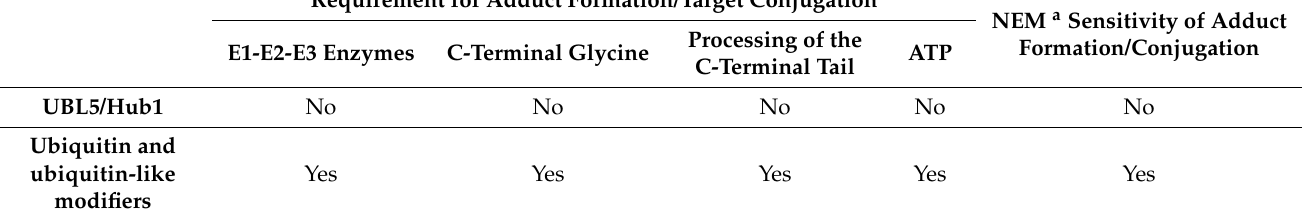
Table 1. Characteristics of adduct formation/target conjugation with UBL5/Hub1 and other members of ubiquitin-like protein